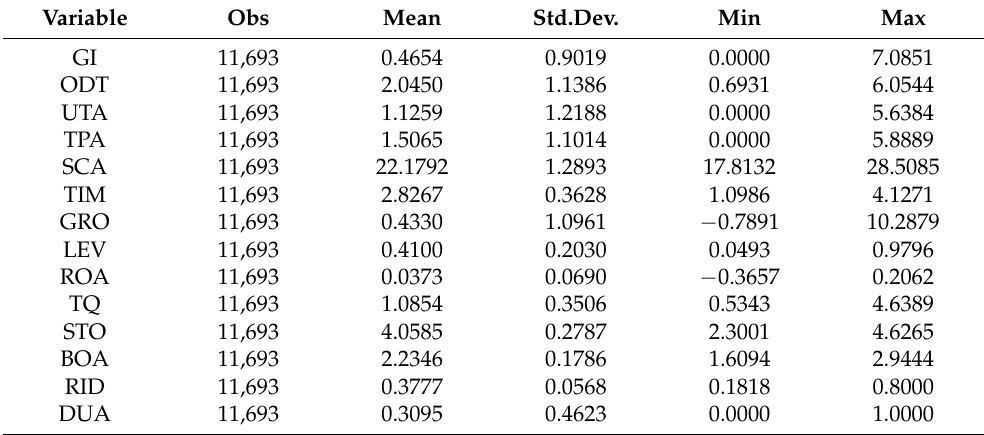
Table 2. Descriptive statistics of main